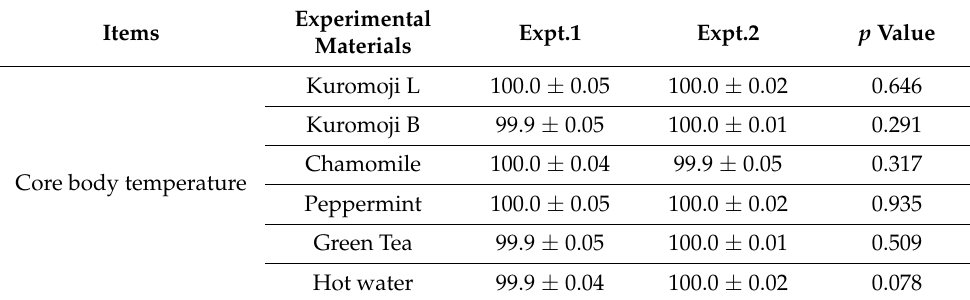
Table 4. Relative values for core body temperature.